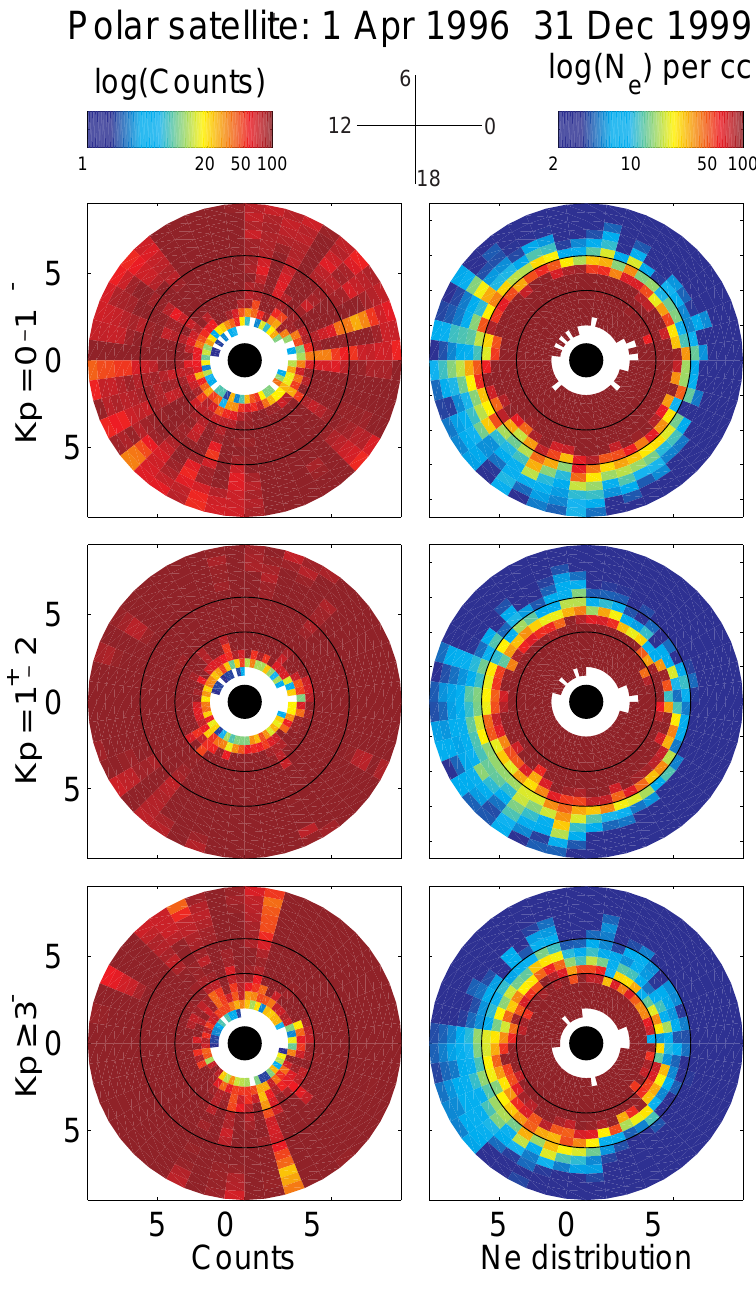
Fig. 4. Right panels: Average electron density distributions (scales in R E ) in the inner magnetosphere mapped to the magnetic equator (i.e. within L = 9). The panels from top to bottom repre- sent three different K p levels (same as in Fig. 3). The circles in each panel show the equatorial distances of L = 4 and 6. Left panels: Number of counts used for the calculation of the average